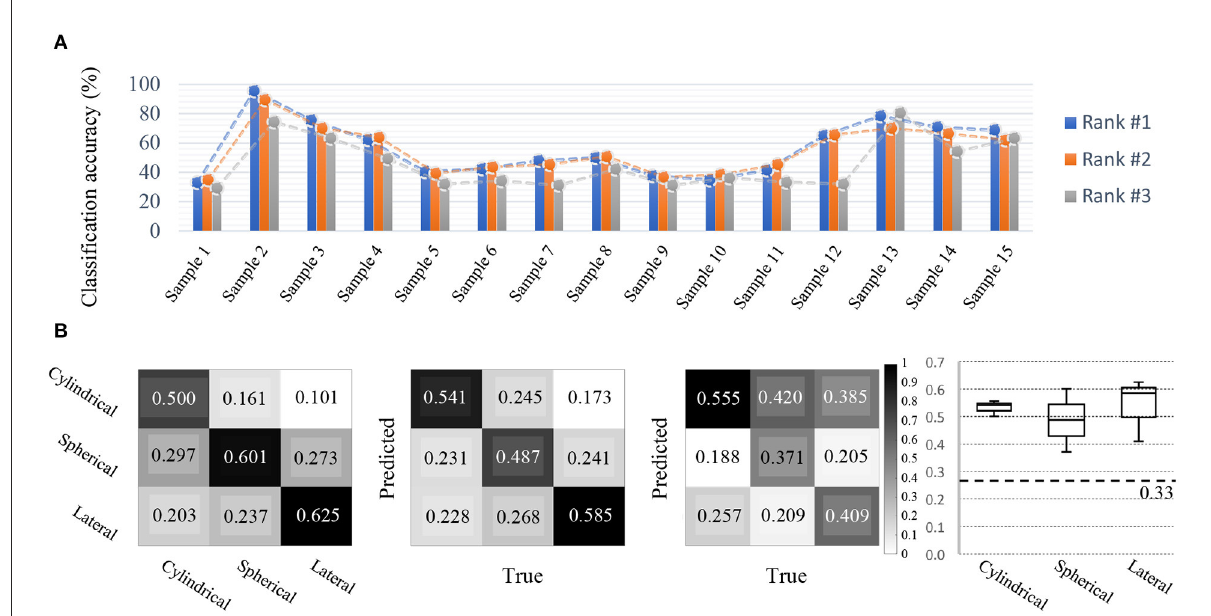
FIGURE10 Competition outcomes. (A) Cross-session BCI results (Accuracy). Compared to other disciplines, all participants achieved relatively good decoding performance. For cross-session BCI, various grasping MIs using a single-arm were performed, and the top-3 BCI model performances during various sessions were acceptable per each class. (B) Confusion metrices for each class and candle plot for comparison. Based on the results of the top-3 participants, the prediction by class and the true answer rate are organized into confusion metrics. From the left, metrices showing which class was predicted more accurately by Rank 1, Rank 2, and Rank 3 participants. The candle plot on the far right corresponds to classes Cylindrical, Spherical, and Lateral, respectively, from the left, and representing the mean and standard deviation of the classification results achieved by the top-3 participants by